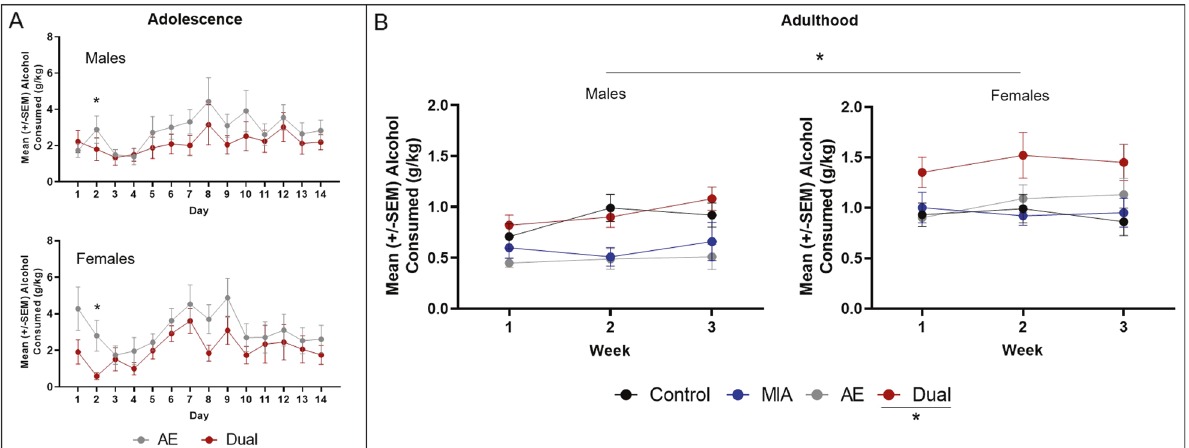
Fig. 3 The impact of MIA and AE on offspring drinking behavior. A Average alcohol consumed (g/kg) during adolescence (P 28 – 42) in male and female offspring from dams exposed to polyI:C (Dual) or saline (AE). There were no signi fi cant differences between groups, except during session 2 ( p > 0.05; n = 9 – 11/group/sex from 4 dams). B Average alcohol consumed (g/kg) in a limited access paradigm across 3 weeks in adult control, MIA, AE, and dual rats. Drinking rates increased across time in all groups ( p = 0.05), but Dual offspring drank signi fi cantly more alcohol than all other groups during weeks 2 and 3 ( p < 0.05; n = 8 – 11/group/sex from 12 dams). Female rats drank more alcohol than males ( p < tests showing that polyI:C dams drank less water and gained less weight than control dams for the fi rst 24 hours post injection